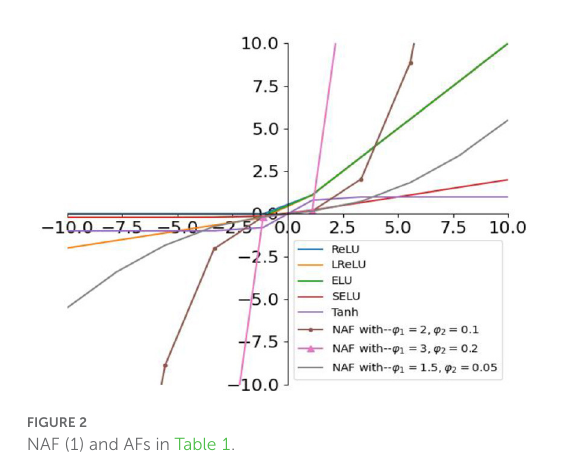
FIGURE2 NAF (1) and AFs in Table